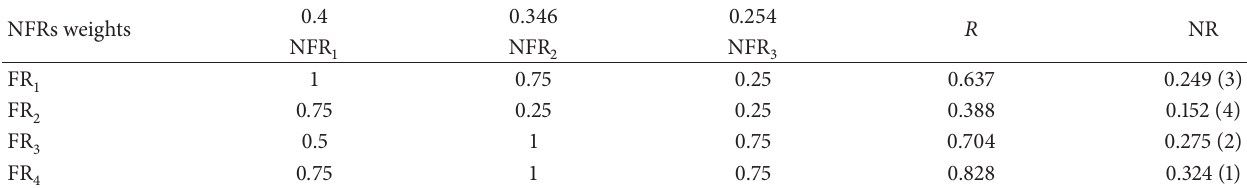
Table 5: Example of computing FRs priority vector.